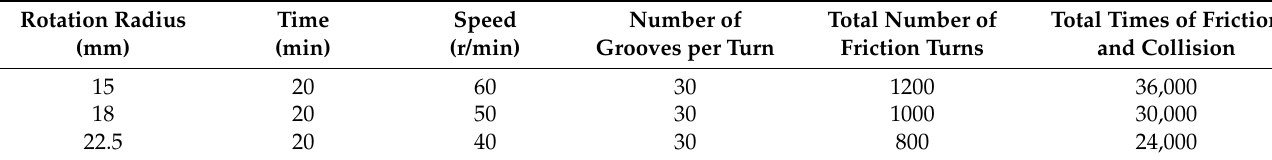
Table 6. Collision parameters with different rotation